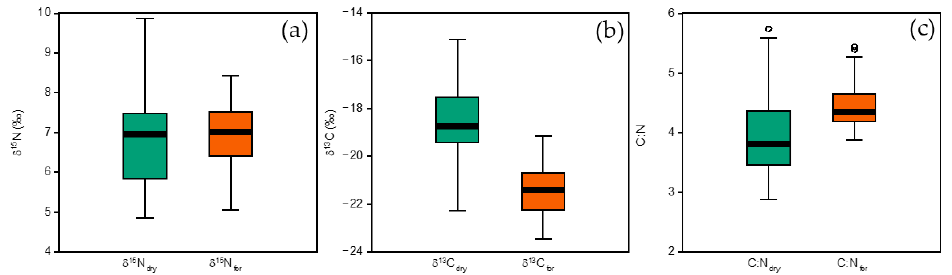
Figure 1. Box plot of ( a ) δ 15 N, ( b ) δ 13 C, and ( c ) C:N of mesozooplankton samples immediately dried after sampling (dry) or preserved in formalin (for). Box: 25 and 75% quartiles; whiskers: 1.5 × the interquartile range; horizontal line: median; circles: outliers (>1.5 × the interquartile range).